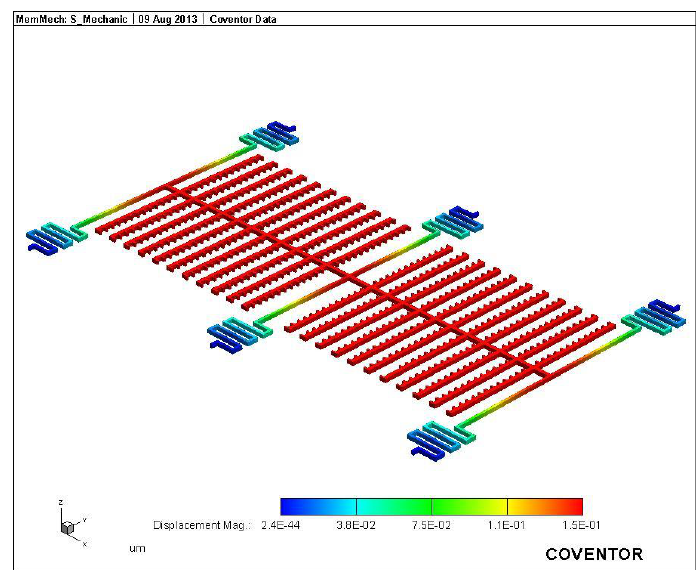
Figure 3. Displacement distribution of the magnetic sensor (unit: µm).